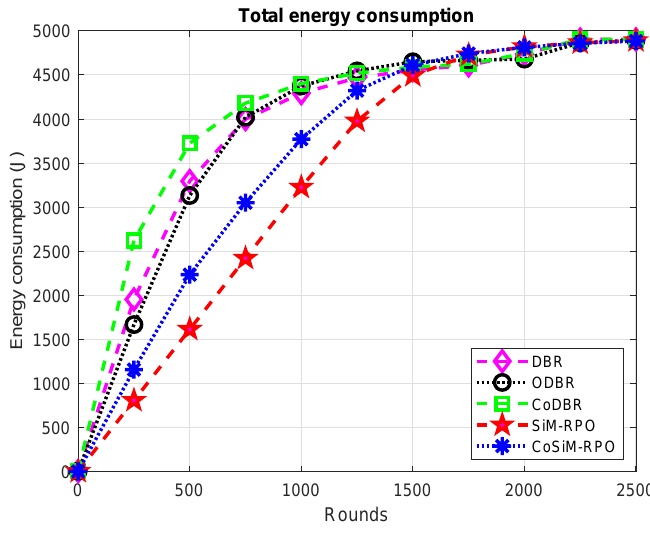
Figure 6. Consumption of